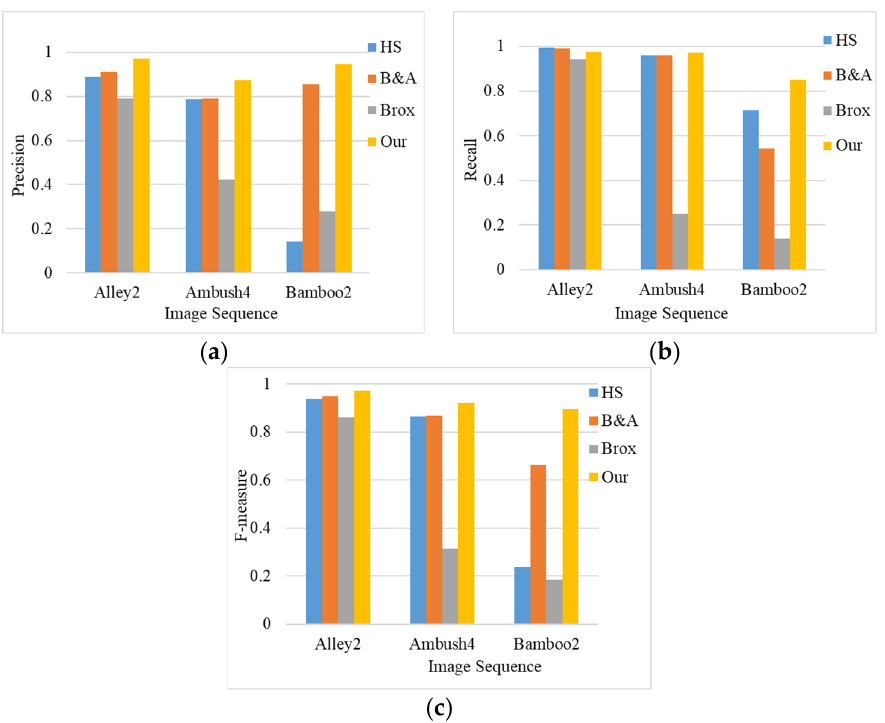
Figure 10. Performance comparison of moving object detection algorithms. ( a ) is the accuracy rate comparison result. ( b ) is the recall rate comparison result. ( c ) is the F-measure rate comparison